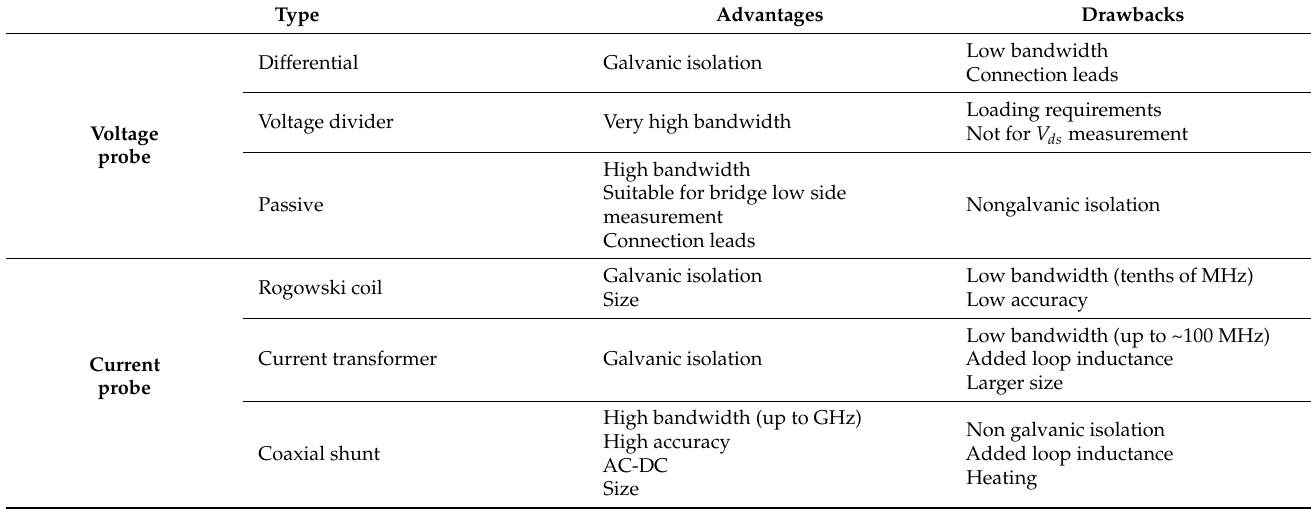
Table 1. Summary of measuring probes